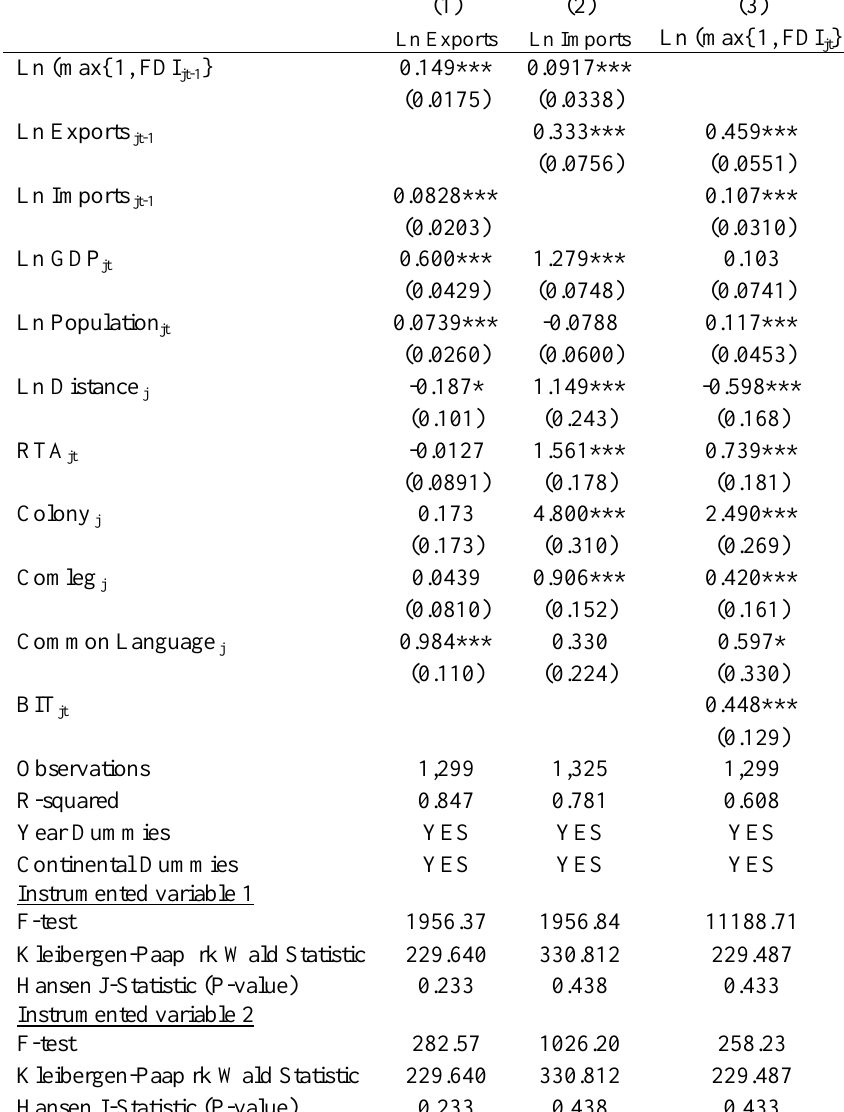
Table 4 . Results with Instrumental